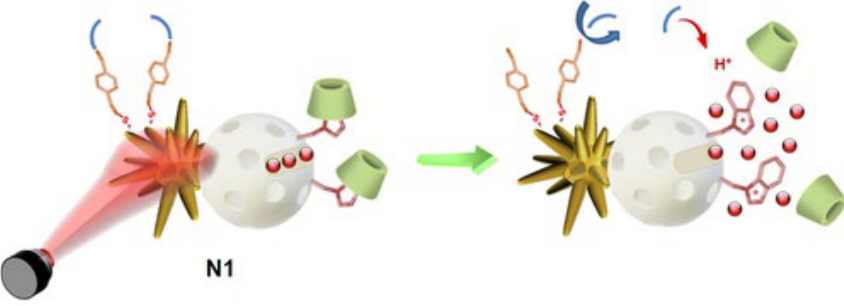
Figure 12. Janus gold nanostar–mesoporous silica nanoparticle (white sphere) for the release of dox- orubicin (red dots). Cyclodextrin gates are in green colour. Reproduced with permission from [108]. Reproduced with permission. Copyright © American Chemical Society.